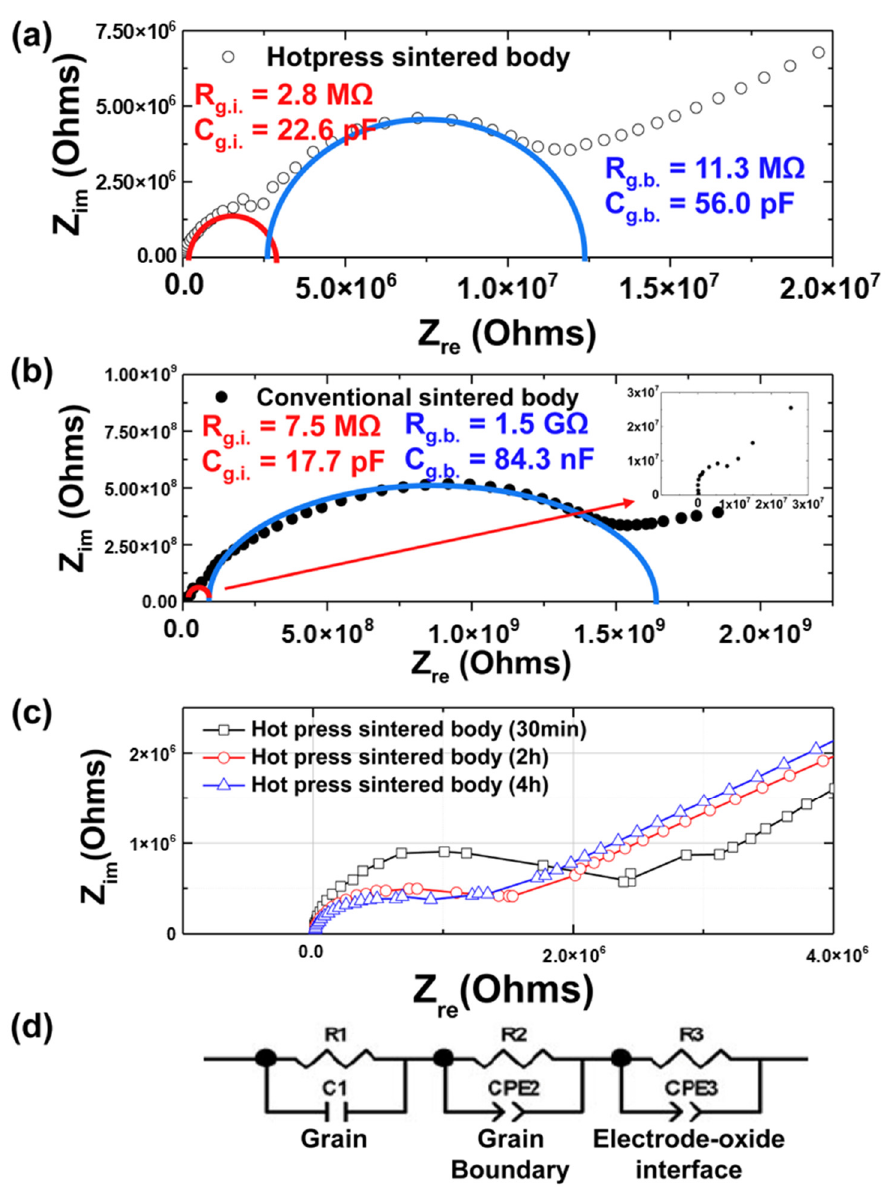
Figure 6. Complex impedance plane of ( a ) the hot-press-sintered body and ( b ) conventionally sintered body. The samples in both ( a , b ) were sintered at 1400 °C for 2 h. ( c ) Results of impedance spectroscopy for different soaking times. ( d ) Equivalent circuit model for the sintered body.